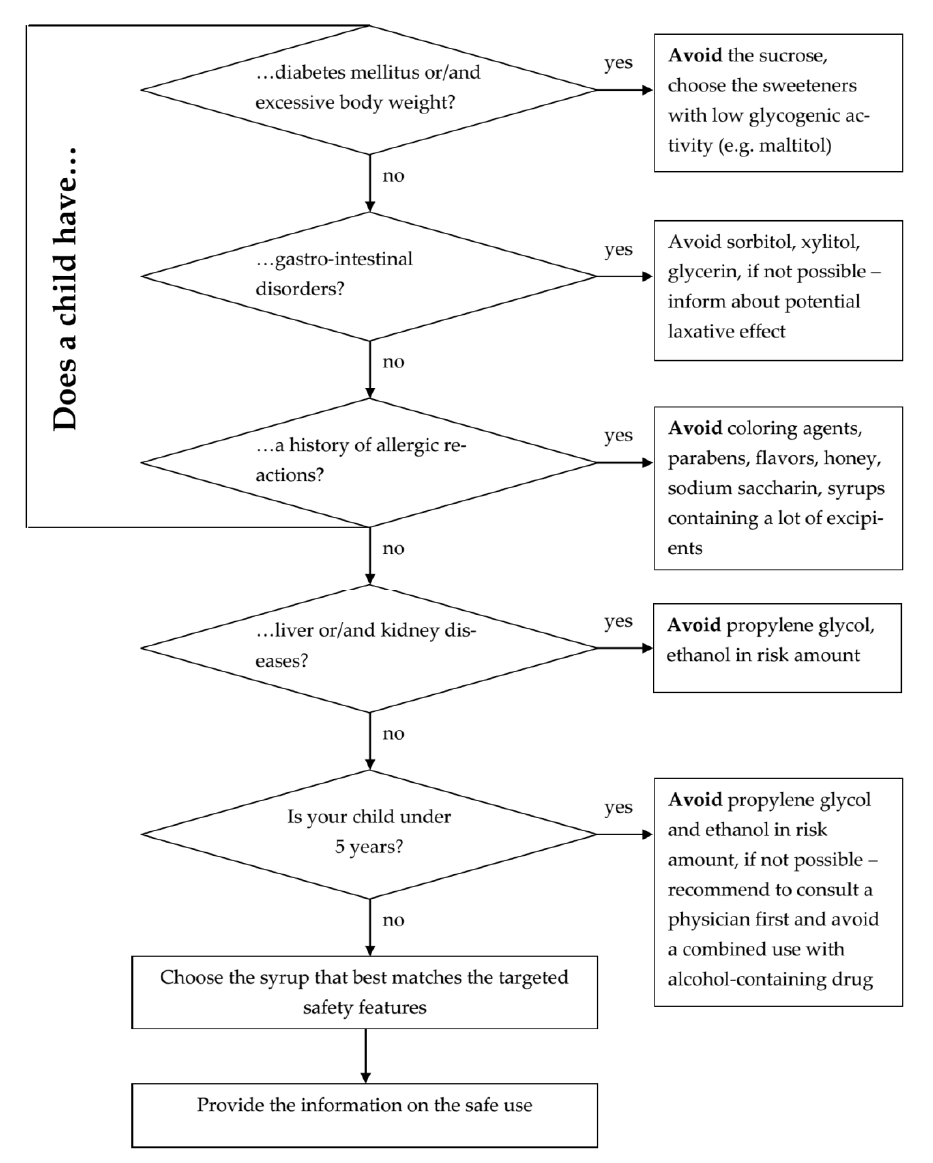
Figure 4. A pharmacist decision-tool for dispense of pediatric phytomucolytic sough syrup.